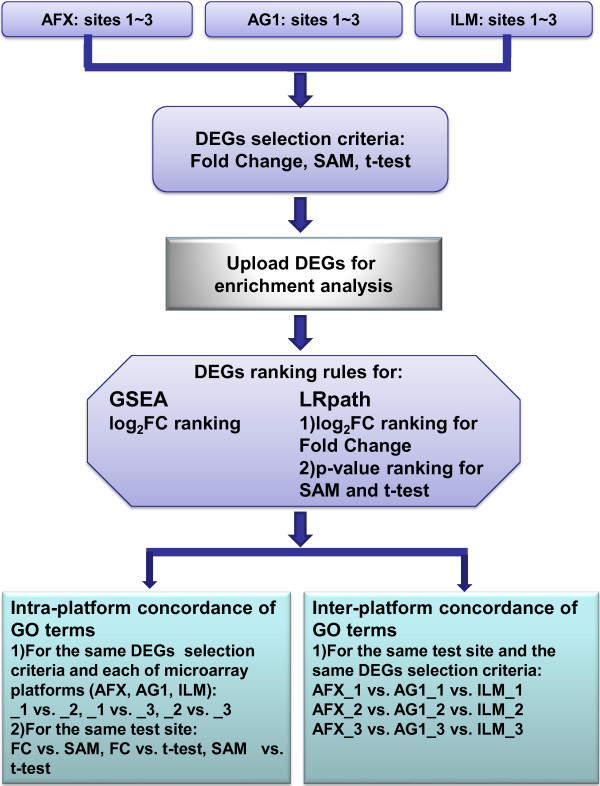
Schematic overview of the concordance analysis of enriched gene ontology terms. The _1, _2 and _3 suffixes refer to test site location. DEGs refer to differentially expressed genes.